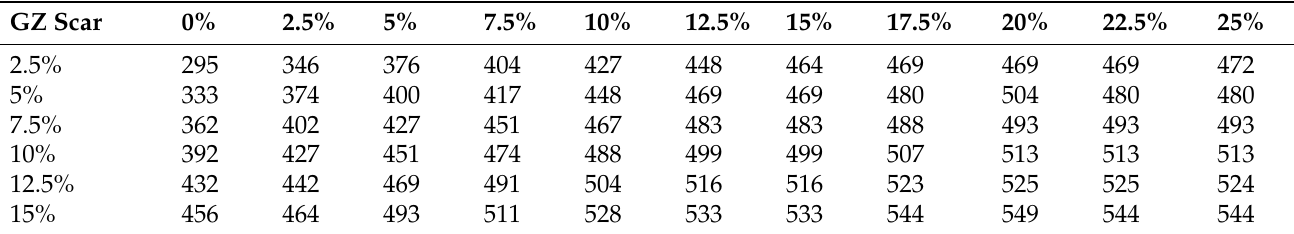
Table 1. Wave rotation period (in milliseconds) for different gray zone size (horizontally), and for different size of the scar (vertically) expressed as the percentage of healthy tissue.